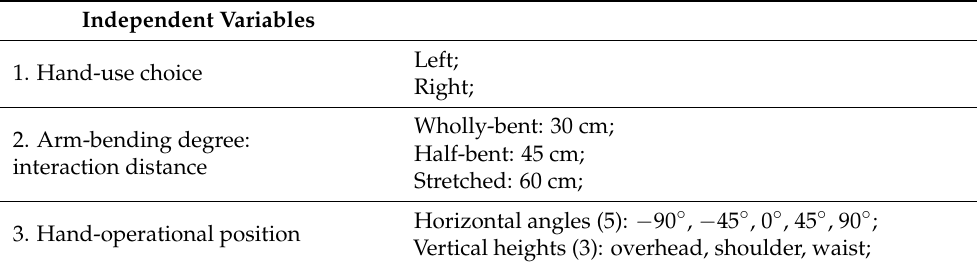
Table 1. A summary of the independent variables in